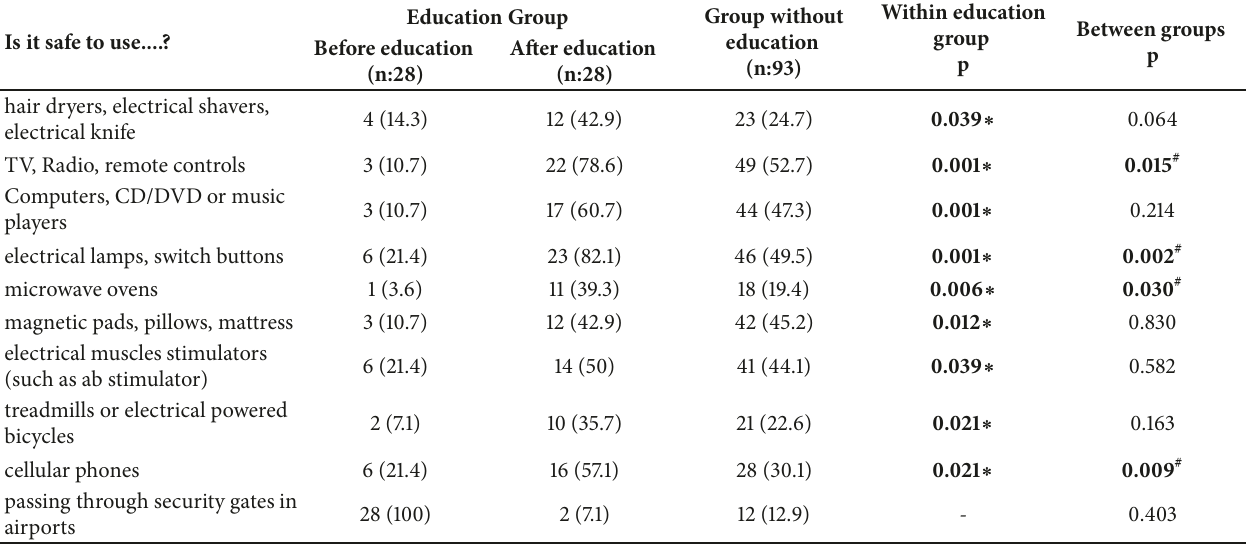
Table4:Correctresponsestoquestionsonsafetyofhouseholdappliancesforelectromagneticinterferencewithcardiacimplantableelectronic